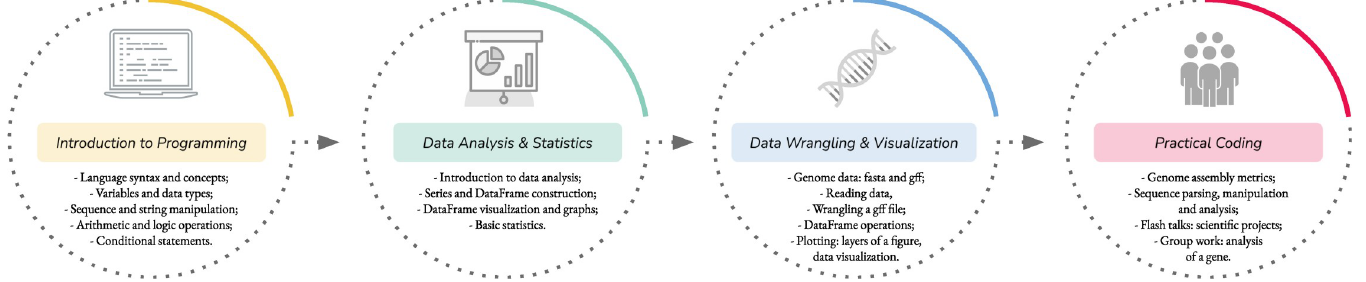
Fig 3. Overview of the workshop topics and activities involving learned skills over the 4 days of the Brazilian Python Workshop for Biological Data in 2020 (detailed schedule of the workshop is provided as S1 Table and all the Python built-in functionalities and libraries used are provided in S3 Table).